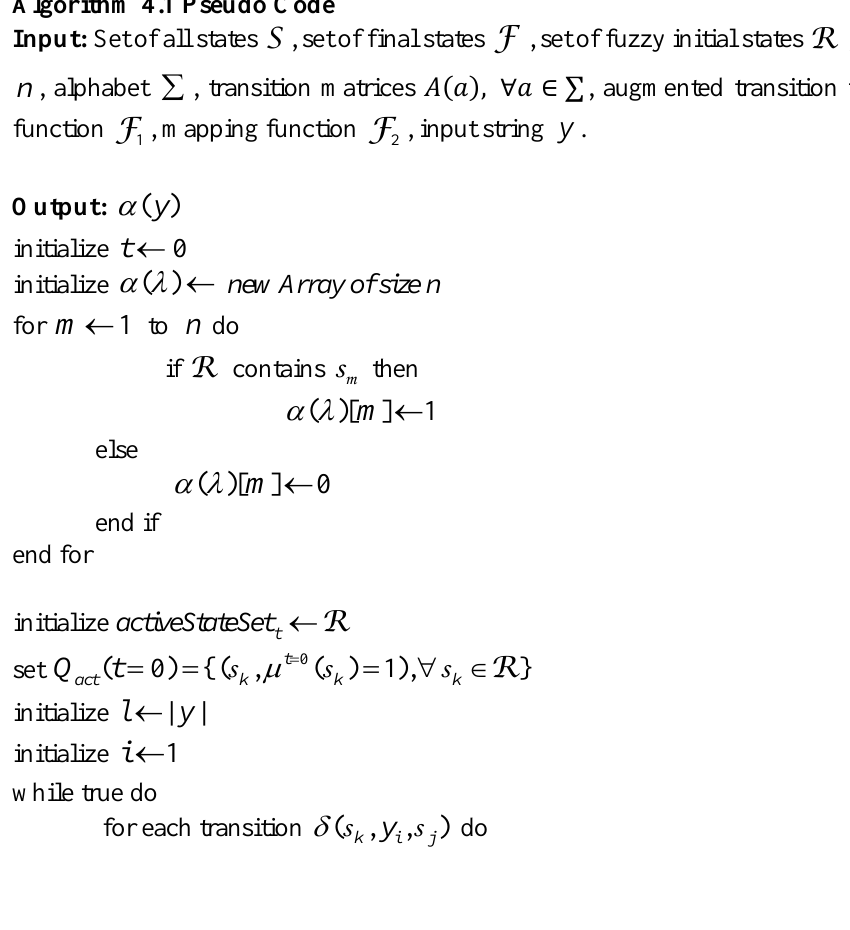
Algorithm 4.1 Pseudo